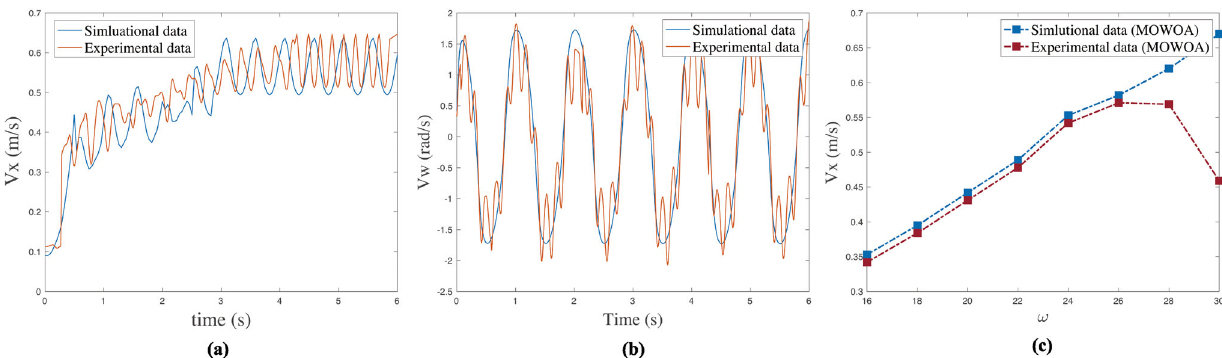
ities of the propulsion speed in x direction under different values of ω . The remaining parameters used here are obtained by MOWOA, as